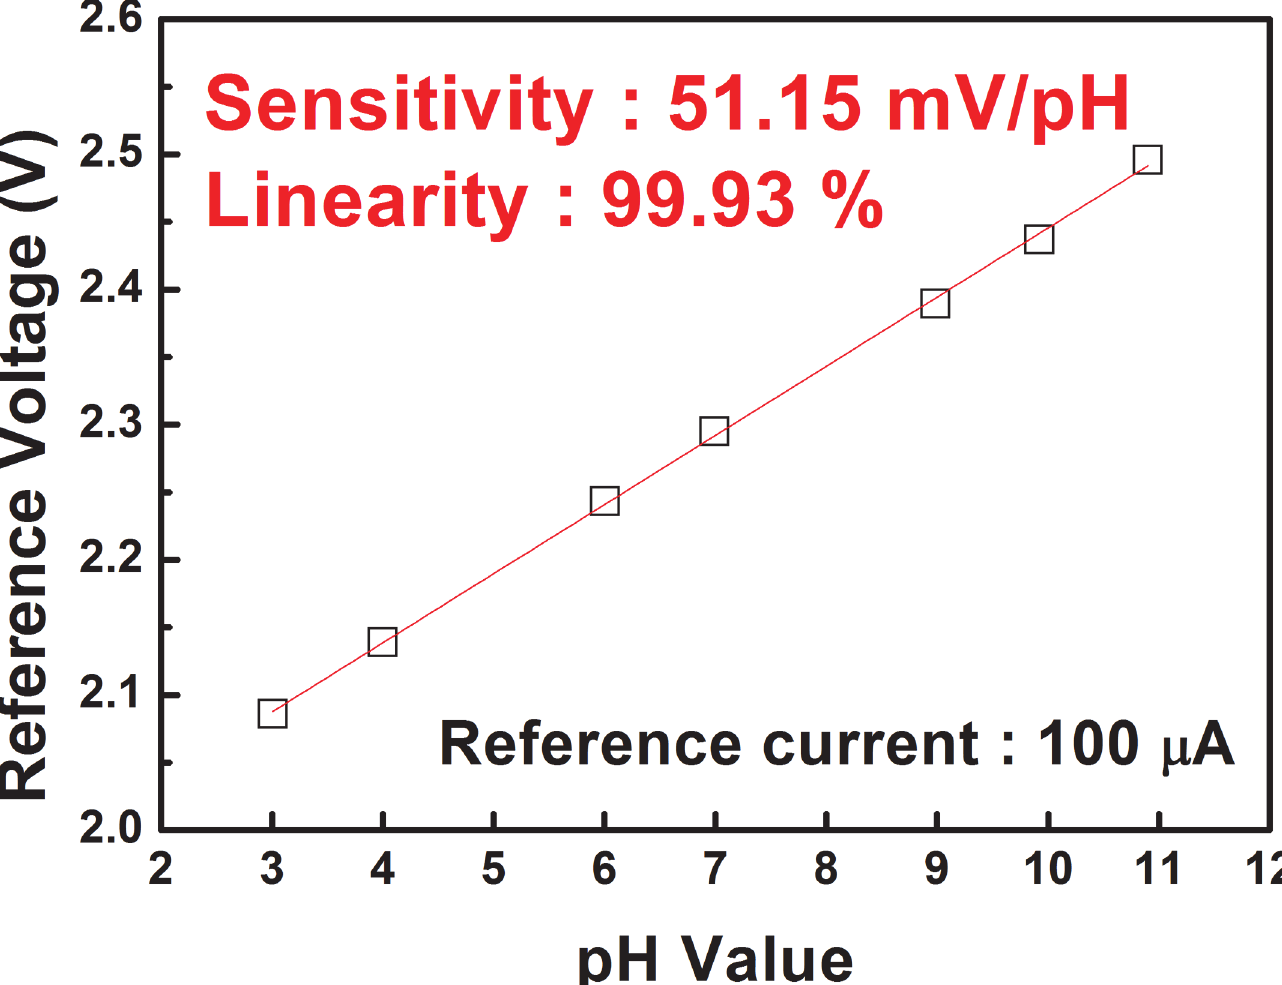
Fig 2. Effect of the pH on the sensitivity of SnO 2 membrane. The reference voltage (V) is shown as a function of pH evaluated at a reference current of 100 μ